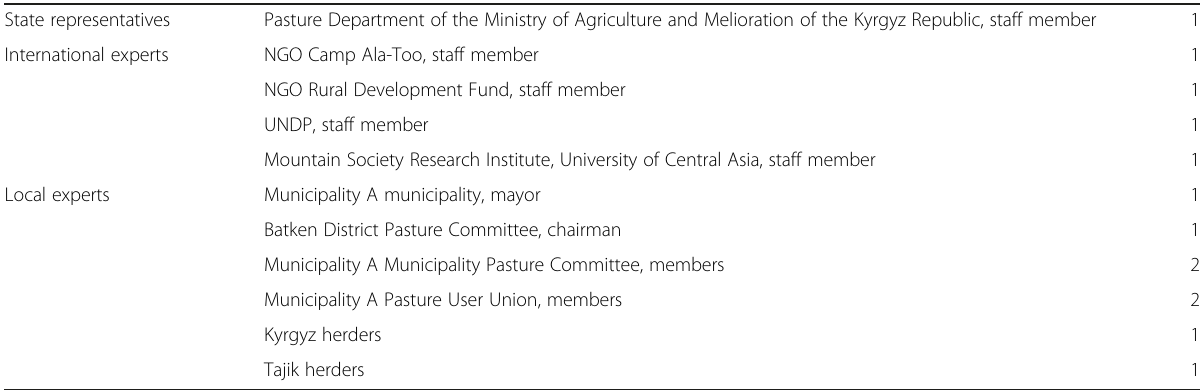
Table 1 List of respondents State representatives